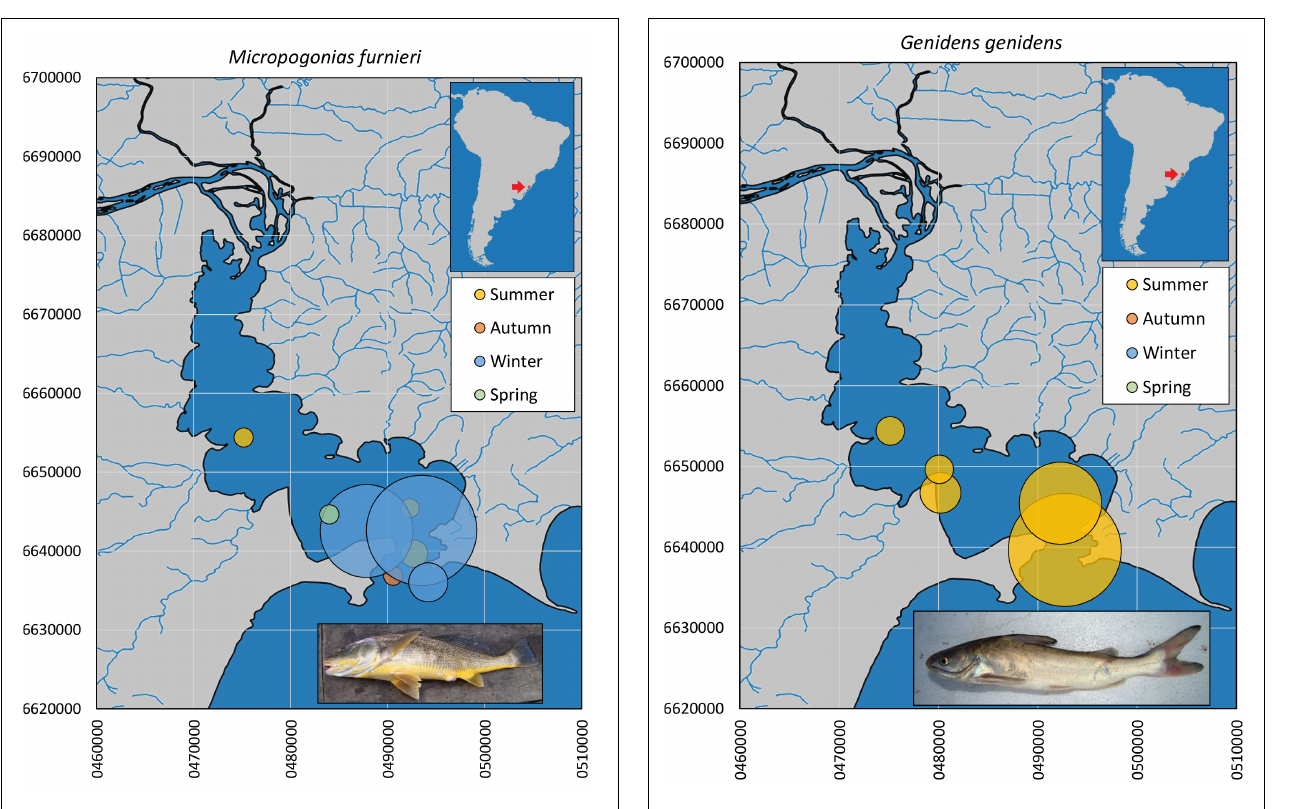
FIGURE 6 | Spatial and seasonal relative abundance of M. furnieri in Guaíba Lake, southern Brazil. Bubble area proportional to number of captures per site ( n = 63 individuals). Fish photograph from Timm, C.D. available at Fishbase.com. Vector map background from FEPAM open database (http://www.fepam.rs.gov.br/biblioteca/geo/bases_geo.asp). 22J UTM coordinates.